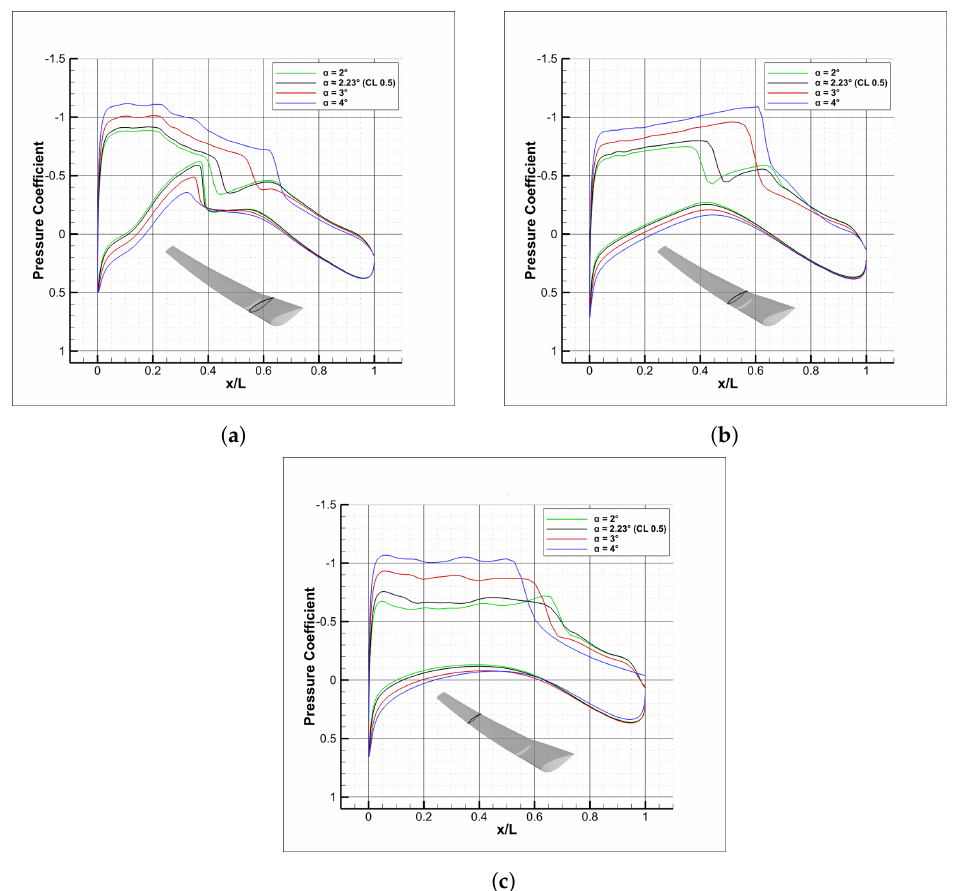
Figure 4. Wing pressure coefficient distribution at different span locations: ( a ) engine inboard., ( b ) engine outboard, and ( c ) wing